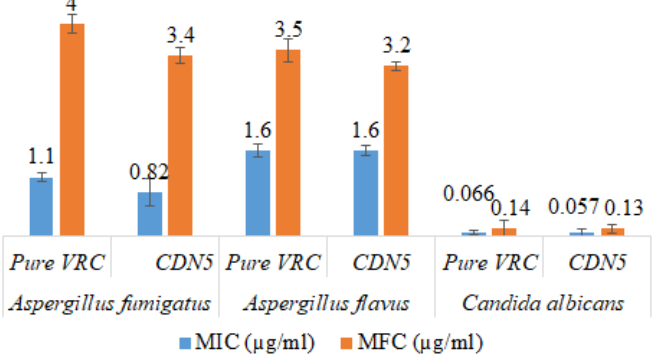
Figure 13. Antifungal activity of CDN5 and pure VRC against various fungal strains (Mean ± SD, n = 5).